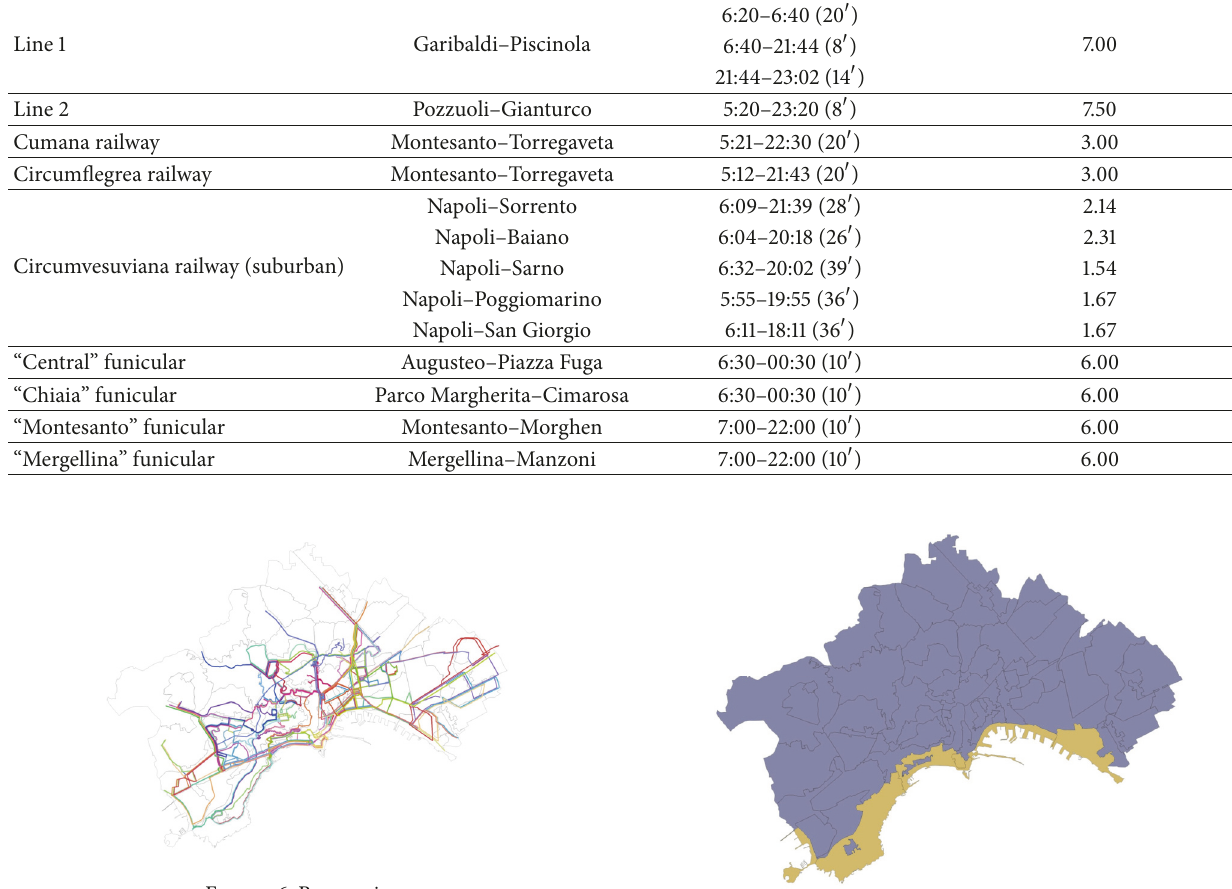
Figure 6: Bus services.